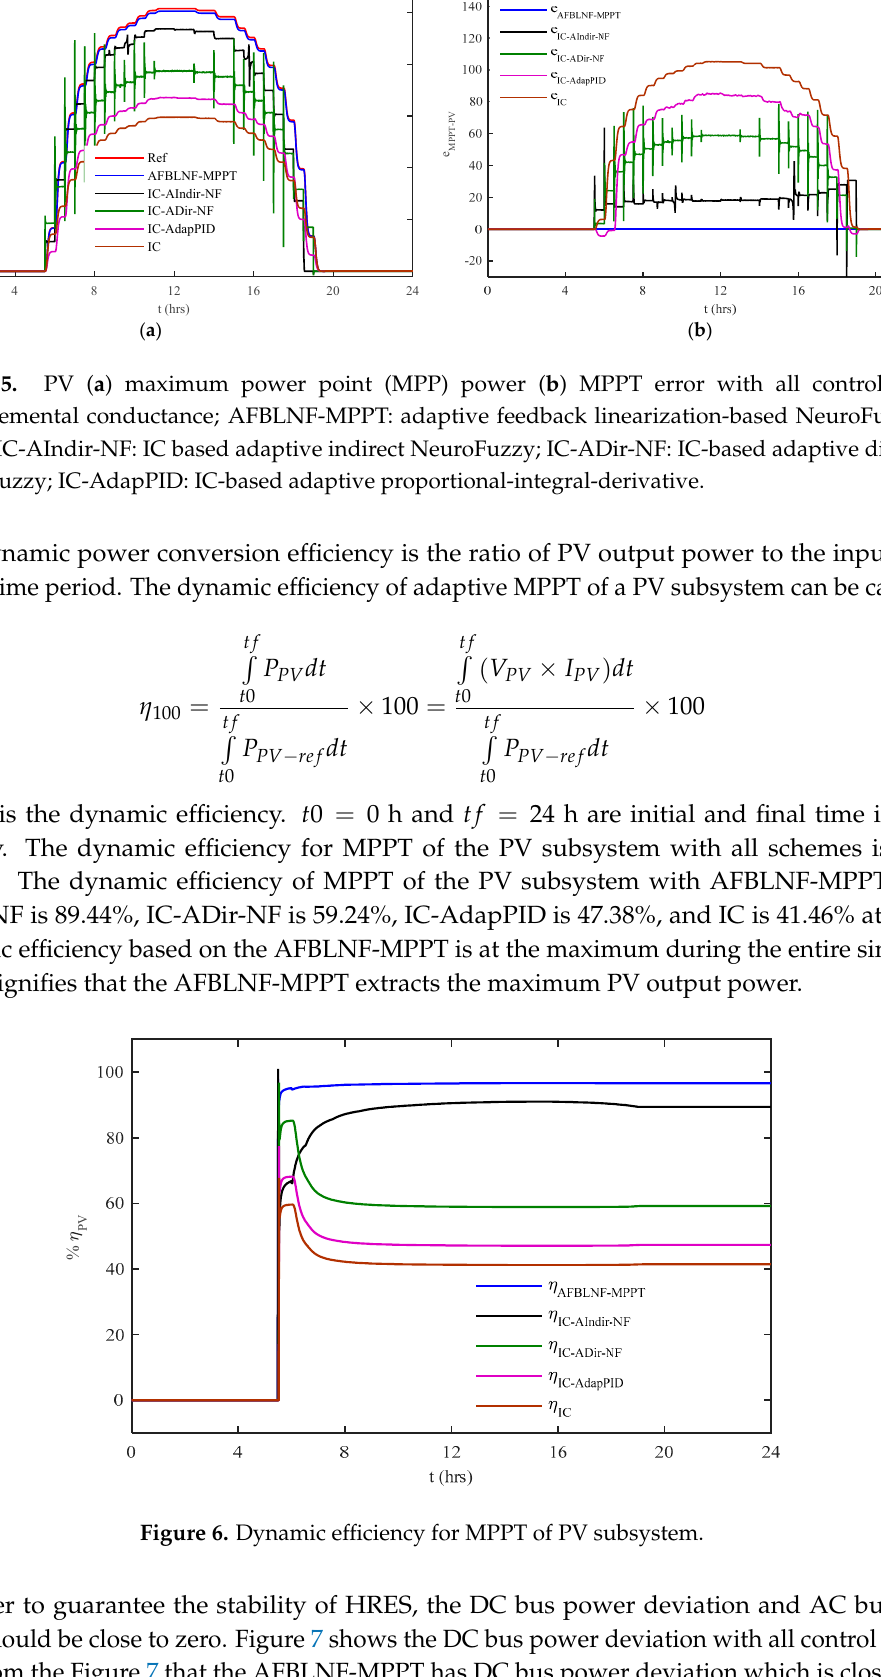
Figure 7. DC bus power deviation. Also, the power deviations on AC bus are presented in Figure 8. The power deviations on AC bus are near to zero using AFBLNF-MPPT compared to the remaining control techniques.